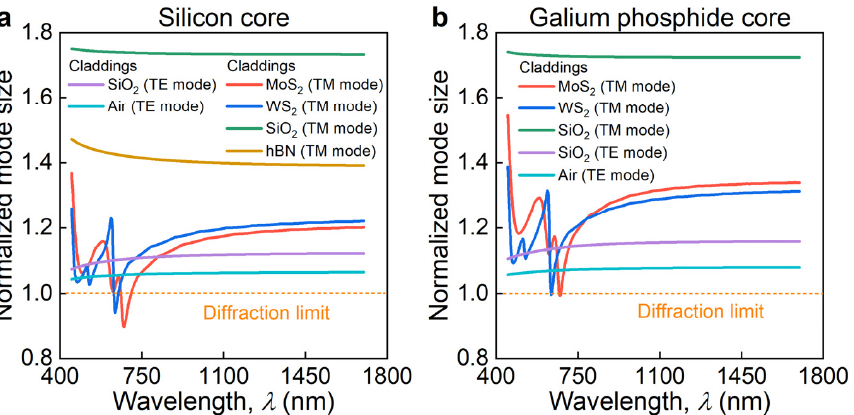
Figure 2. Subdiffraction guiding in waveguides with MoS 2 and WS 2 claddings. ( a ) Silicon core and ( b ) gallium phosphide core. The results for SiO 2 /Si/SiO 2 and SiO 2 /GaP/SiO 2 planar waveguides for both polarizations (TM and TE) are included for comparison. Optical constants, used for calculation, are presented in Appendix A (Figure A1).